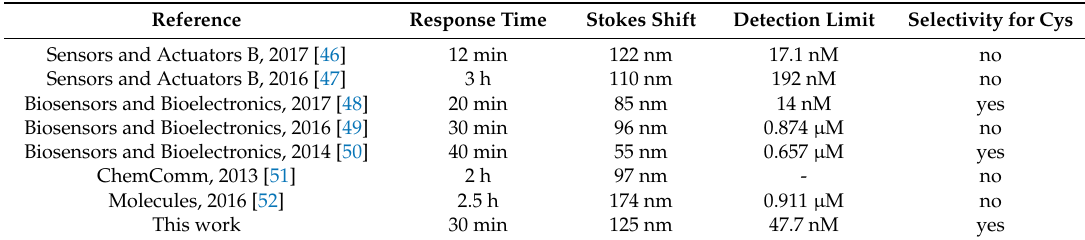
Table 1. Comparison of the probe for the detection of thiols.